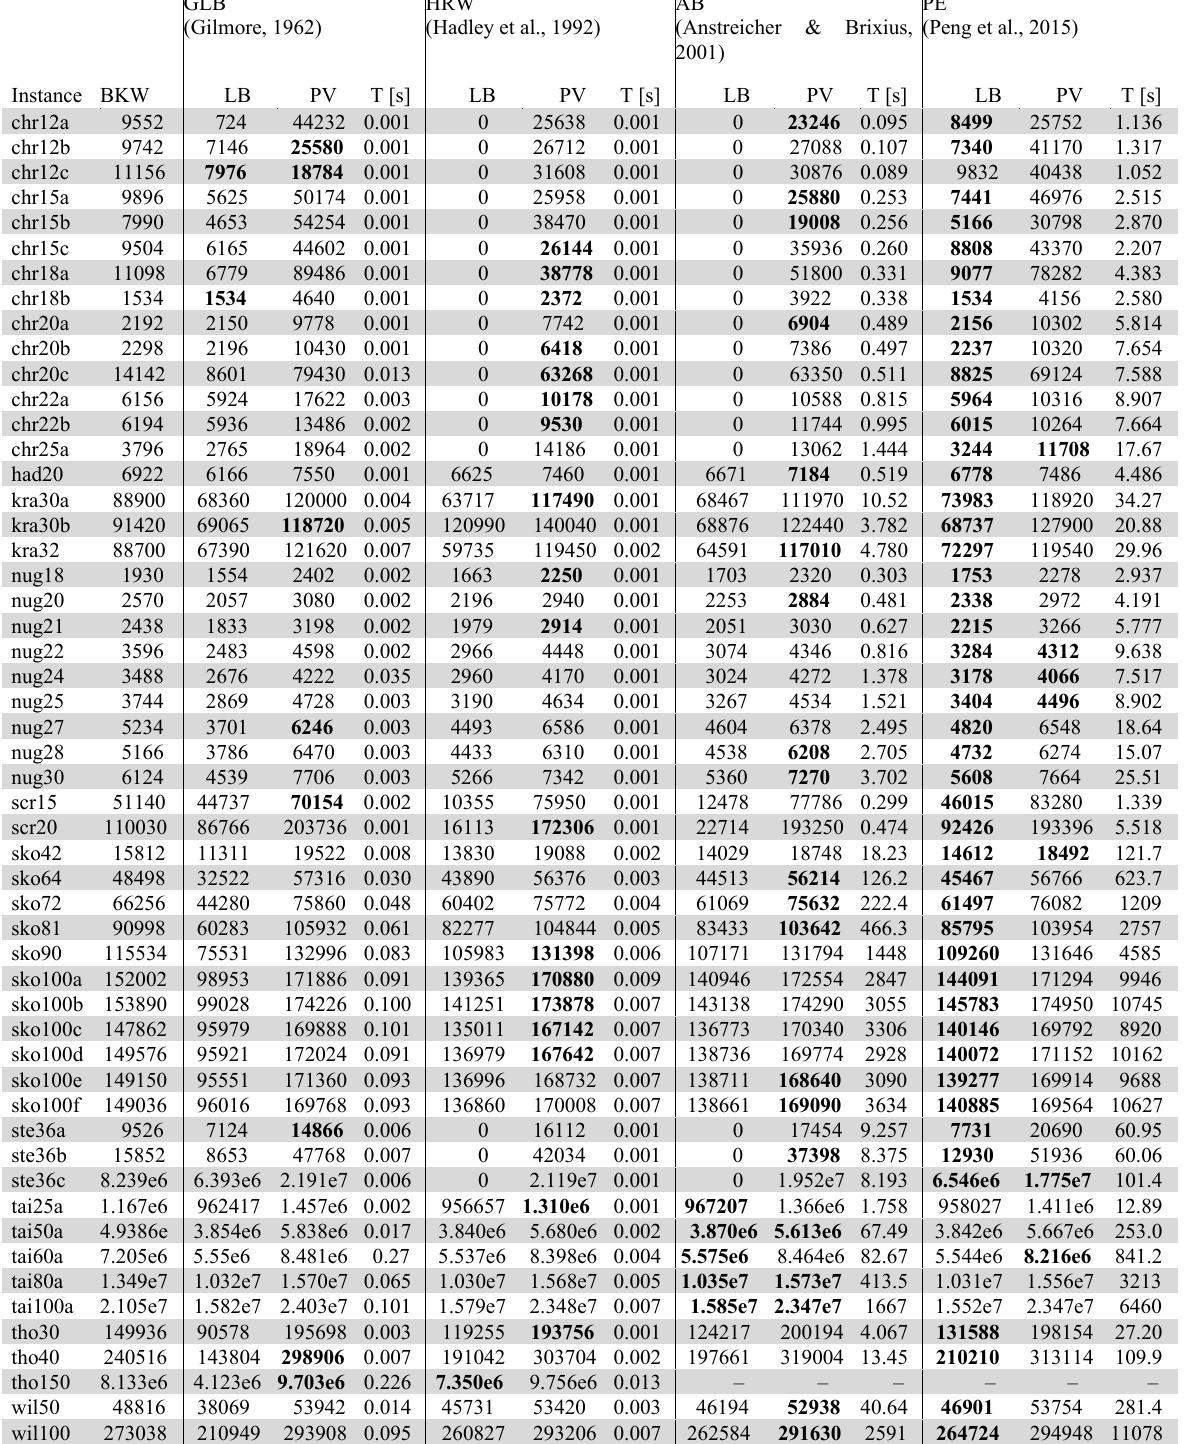
Lower bounds (LB), values of the projections (PV), and computational time (T) of the four considered QAP lower bounding techniques for selected QAPLIB problems (BKW – best known value). Best results (highest for LB and lowest for PV) are emphasized in